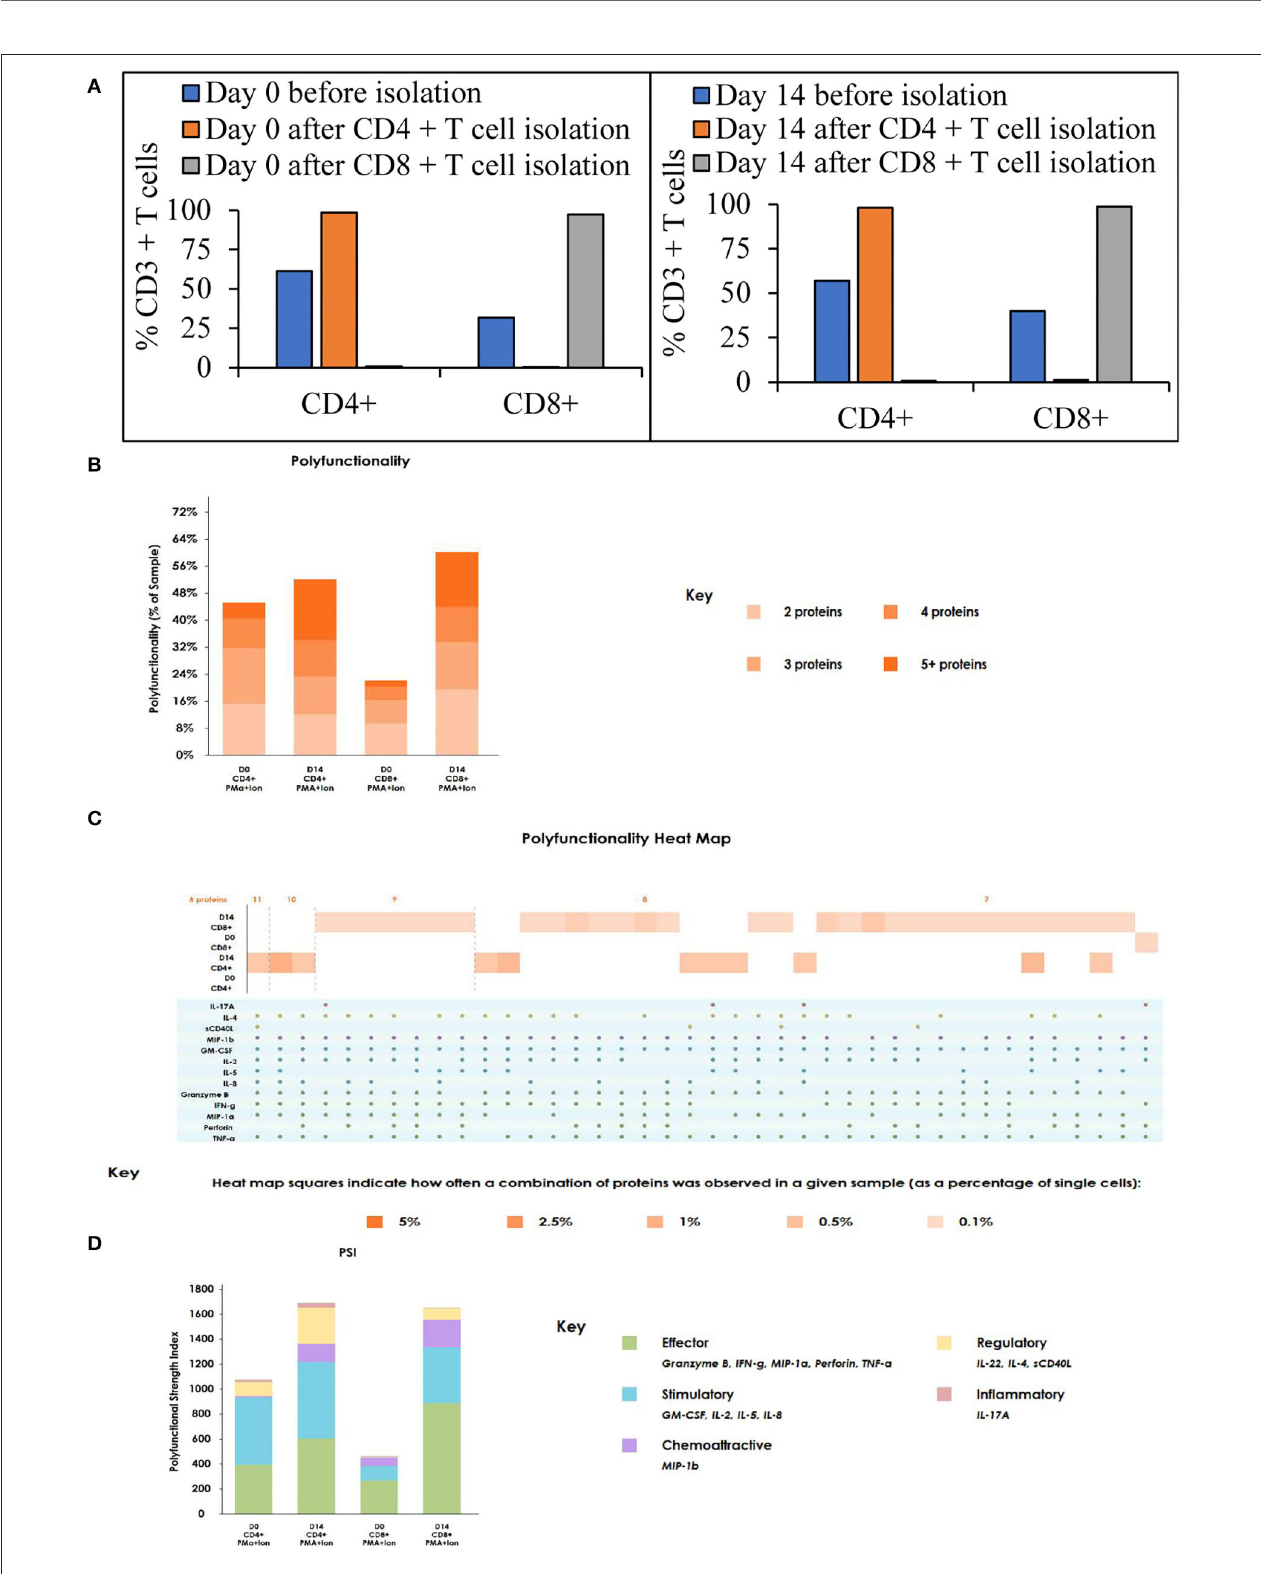
FIGURE 4 | The T cell activation and expansion in stirred-tank bioreactor maintains the polyfunctionality of the T cells: (A) T cell subsets on Day 0 and Day 14 before and after isolation. The values represent average of 50,000 single cells per condition; (B) Polyfunctionality of T cells on day 0 and 14 after stimulation. The values represent average of 50,000 single cells per condition; (C) Heat map of polyfunctionality of T cells shown based on the number of cytokines produced; (D) Polyfunctional strength index of T cells on day 0 and 14 after stimulation. The values represent the average of 3,000 single cells per condition.